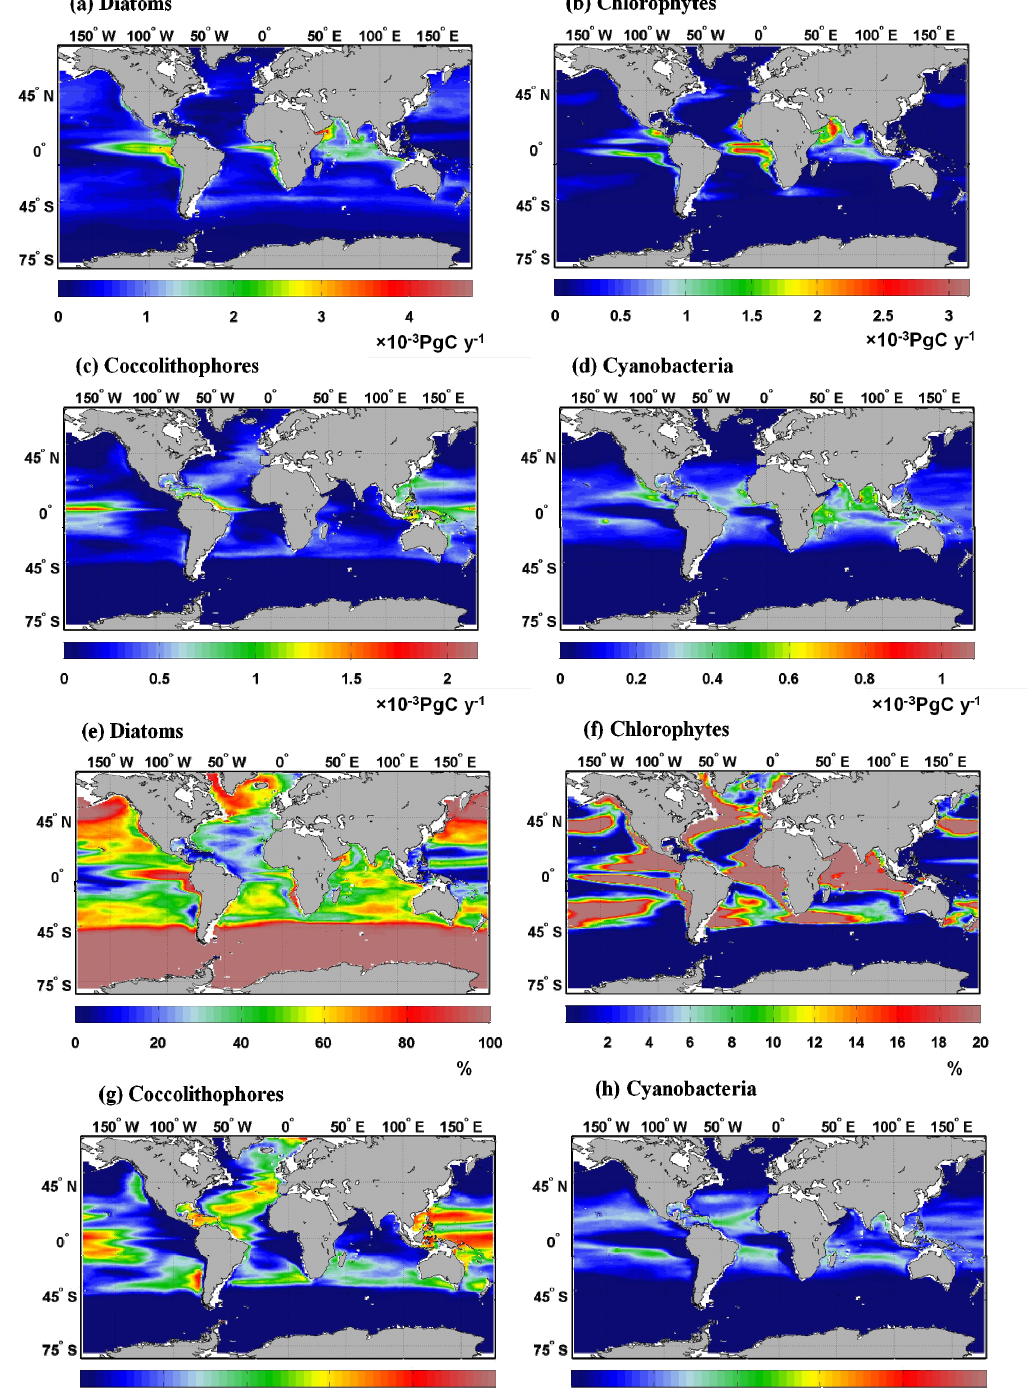
Figure 5. Distribution of model class-specific primary production for the period from 1998 to 2011. ( a – d ) shows the primary production in absolute units. ( e – h ) shows the percent contribution of class-specific production to total primary production. Note the different scale for each